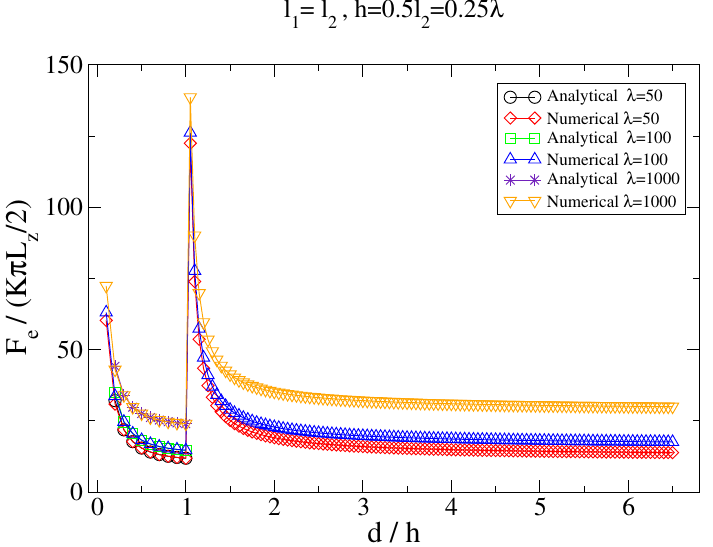
Figure 3. Elastic contribution to the free energy F e of one substrate period as a function of d for the F a states ( d < h ) and the W a states ( d > h ) and substrate relief l 1 = l 2 and h = 0.5 l 2 = 0.25 λ . Three different substrate periods are shown: λ = l 1 + l 2 = 50, 100 and 1000. For the F a states, the numerical results are compared to the analytical results given by Equation